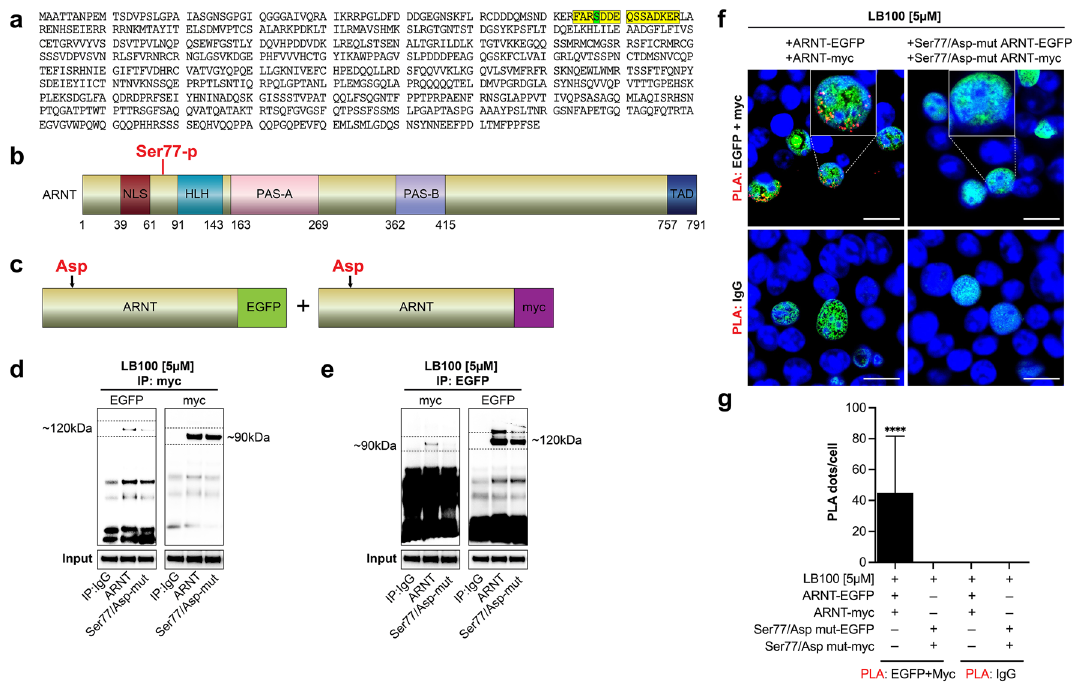
Figure 2. Serine77 phosphorylation site of ARNT is responsible for the homodimer formation. ( a ) ARNT phosphorylation site is identified at the serine on position 4 of the peptide (Ser77 in ARNT) after 5 µM of LB100 treatment. ( b ) Domain organization of ARNT (NLS-nuclear localization domain; bHLH-basic helix loop helix; PAS-periodicity/ARNT/single-minded; TAD-transactivation domain). ( c ) EGFP or myc-tagged wild type ARNT overexpression constructs in which serine 77 was changed to the aspartic acid residue. ( d , e ) Representative immunoblotting for co-immunoprecipitation of EGFP or myc-tagged wildtype and mutated ARNT expression construct after 4 h of LB100 treatment (5 µM). ( f ) Representative confocal images of proximity ligation assay (PLA) for EGFP and myc-tagged wild type and mutated ARNT expressing HEK293 cells after LB100 (5 µM) treatment. Scale bars: 15 µm. ( g ) Quantitative analysis showing PLA signals, measured as dots per cells (N = 20 cells). ****p < 0.0001, 1-way ANOVA versus IgG. Data are shown as mean ±